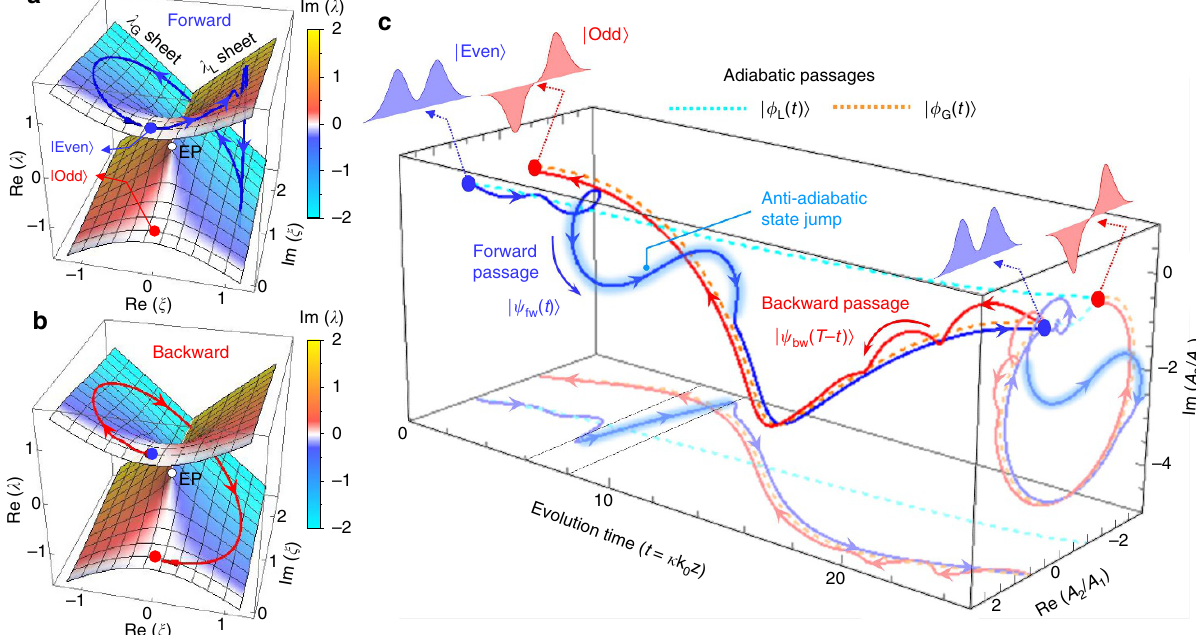
Figure 3 | Time-asymmetric evolution properties in the unidirectional converter region. ( a , b ) Energy expectation value h H i trajectories for the forward ( a ) and backward ( b ) propagation cases, respectively. ( c ) Time evolution of relative channel amplitudes A 2 / A 1 for the forward and backward propagation cases in comparison with purely adiabatic evolution passages. In stark contrast to the backward passage (red curve) following the adiabatic passage that switches the mode’s transversal symmetry, the forward passage undergoes an anti-adiabatic state jump (the region highlighted in light blue) and consequently the final state maintains the even-transversal symmetry. In ( c ), projections of the dynamic and adiabatic passages onto the t -Re( A 2 / A 1 ) and Re( A 2 / A 1 )-Im( A 2 / A 1 ) planes are provided for better understanding of the time-domain response. The fictitious time domain of the anti-adiabatic jump for the forward passage is indicated by dashed line on the t -Re( A 2 / A 1 ) plane. In this analysis, we calculate | c fw ( t ) i , | c bw ( t ) i and h H i using the classical Runge– Kutta (RK4) method with total evolution-time parameter T ¼ 25.